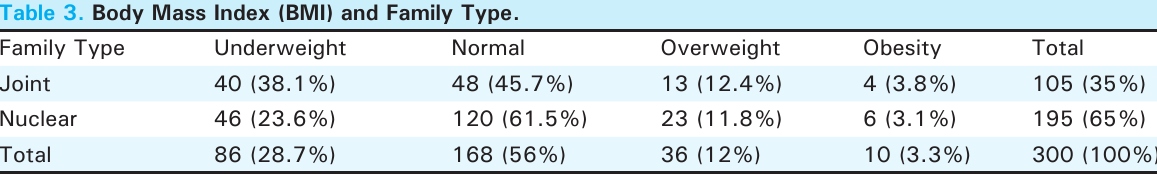
Table 3. Body Mass Index (BMI) and Family Type.